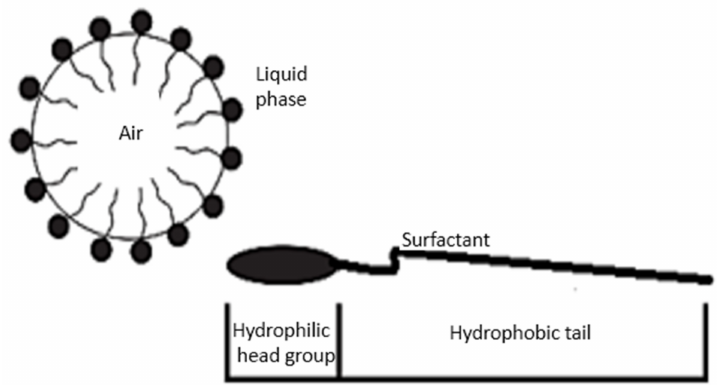
Figure 2. Surfactant molecules at the water–air interface [25,30].